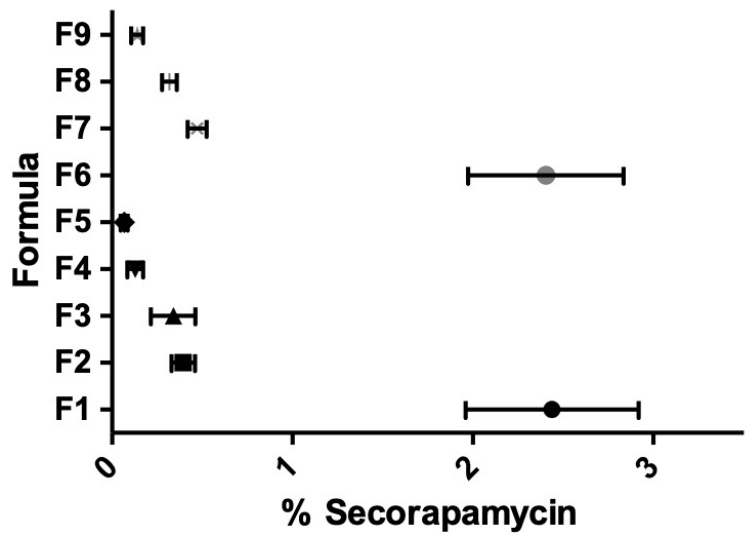
Figure 5. Percentage of secorapamycin, the main degradation product of rapamycin, according to the formulation studied as captioned and described in Table 1